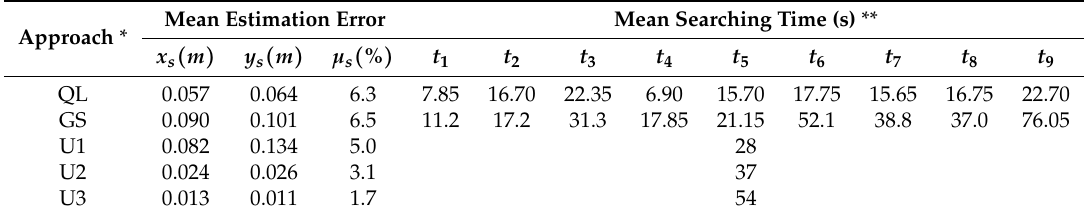
Table 1. Radiation source estimation